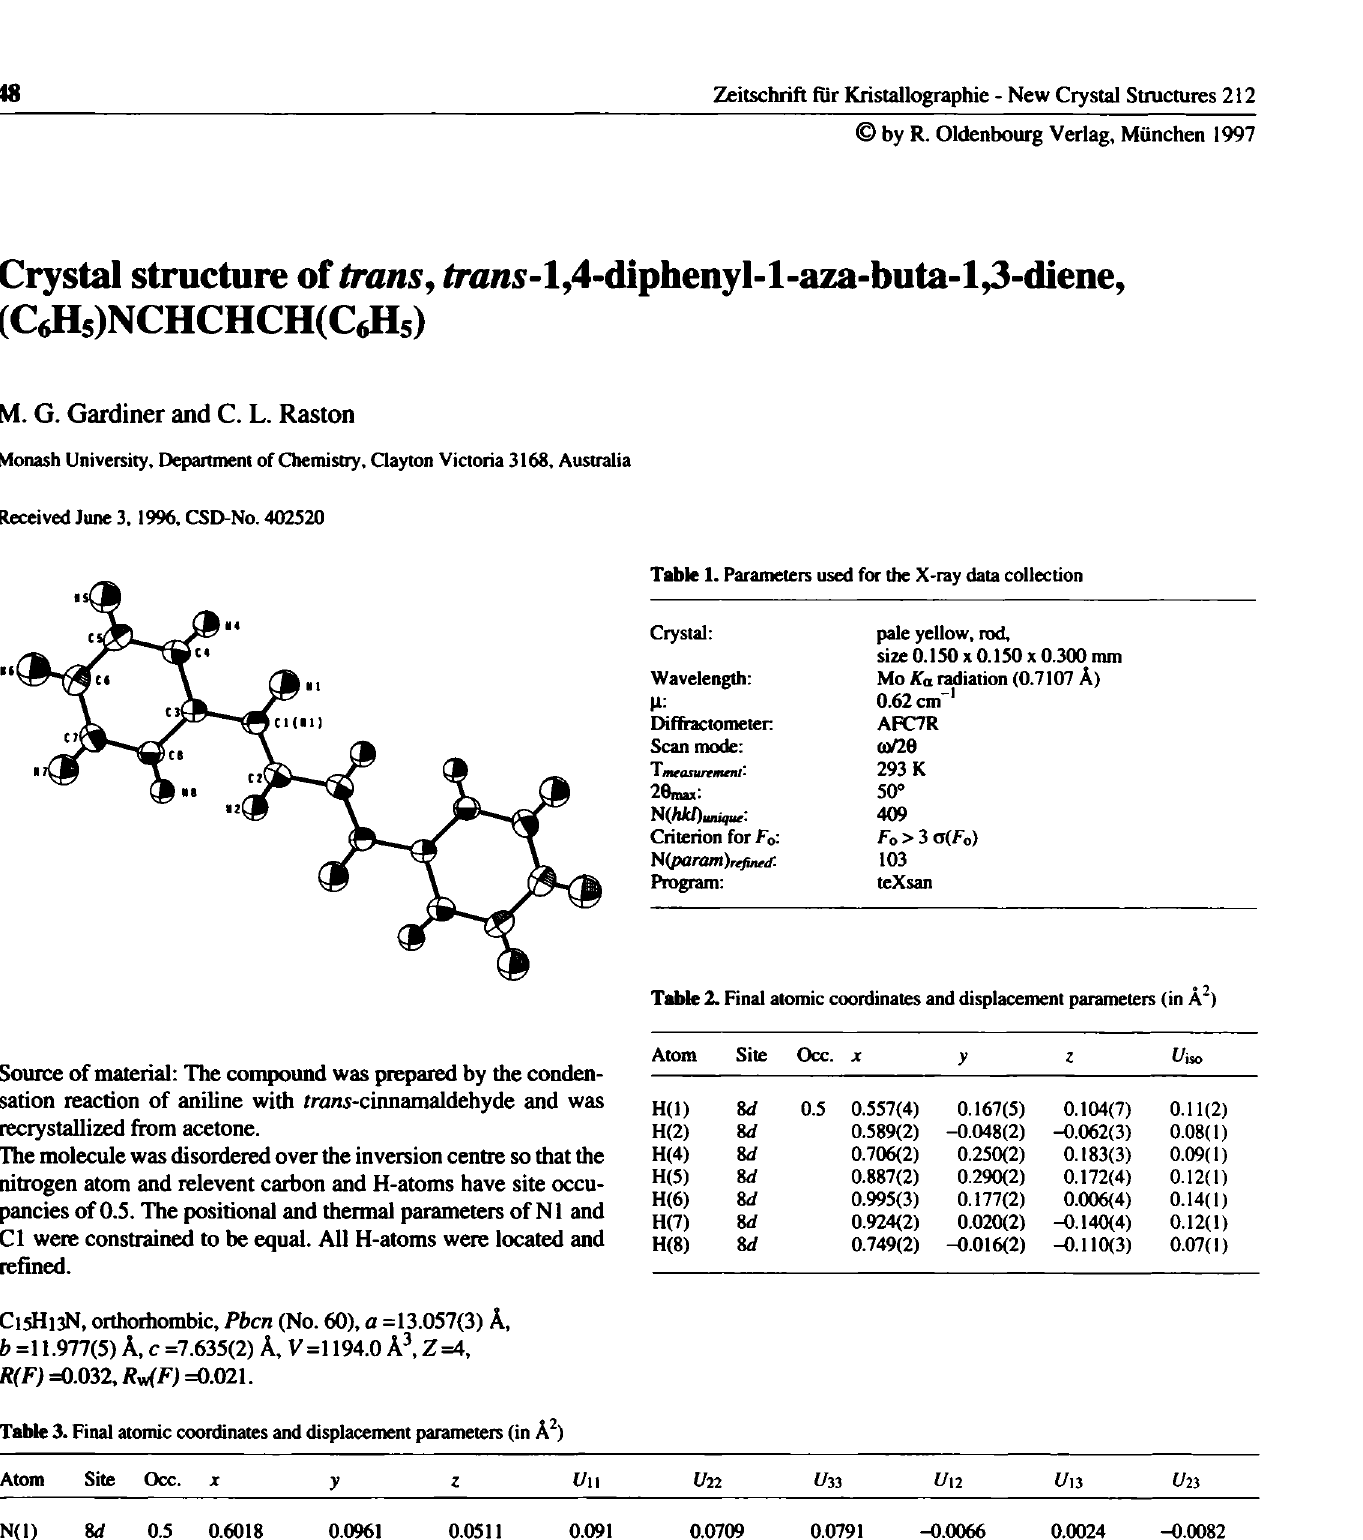
Table 3. Final atomic coordinates and displacement parameters (in Â 2